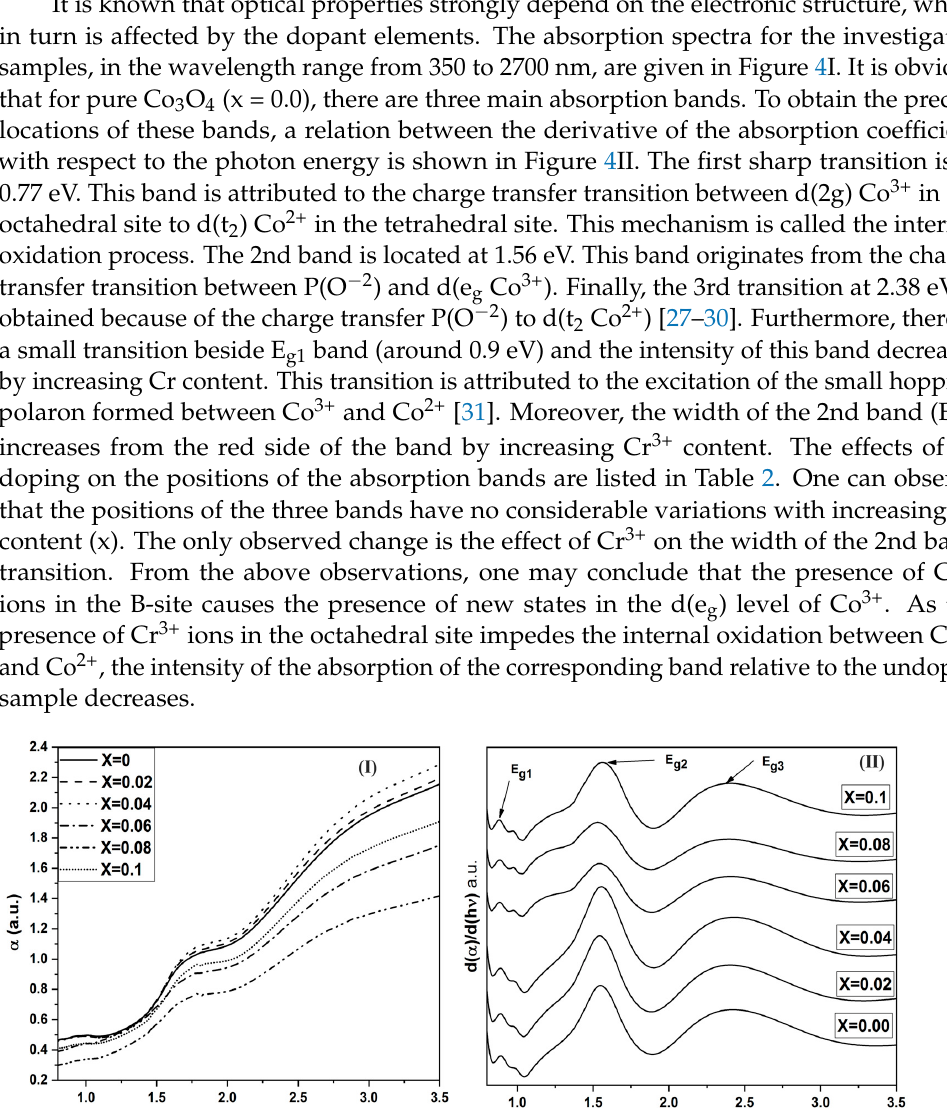
Figure 5. The proposed schematic diagram for the optical energy bands of spinel cobalt oxide .